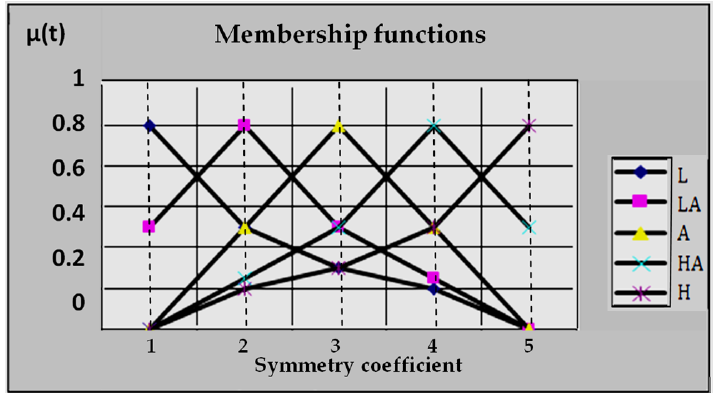
Figure 3. Membership functions of fuzzy terms.